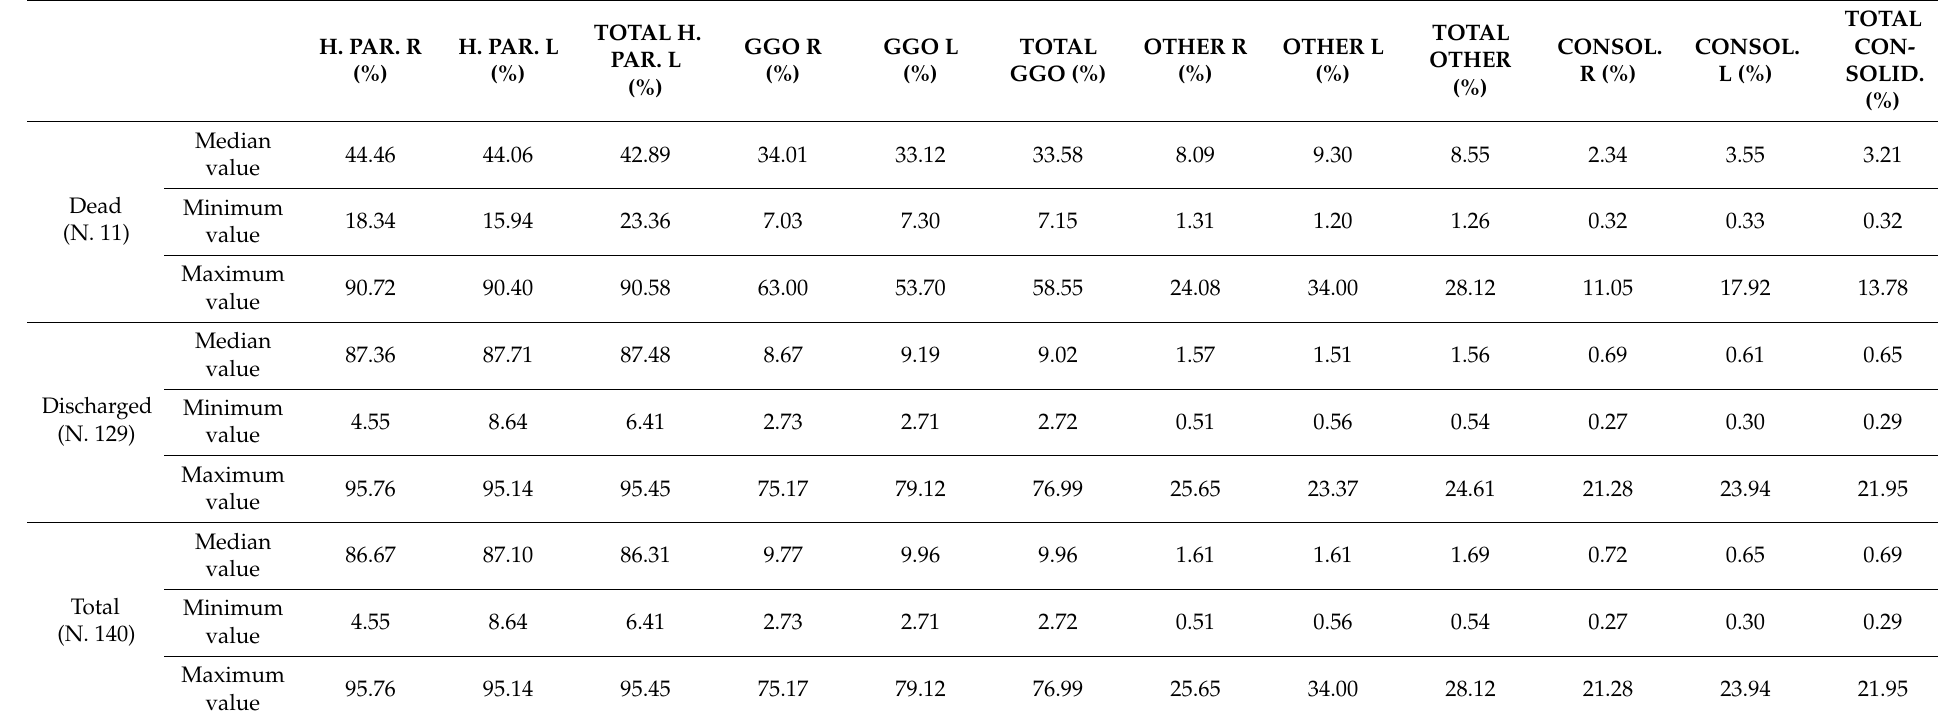
Table 2. Quantified volumes on CT at the last